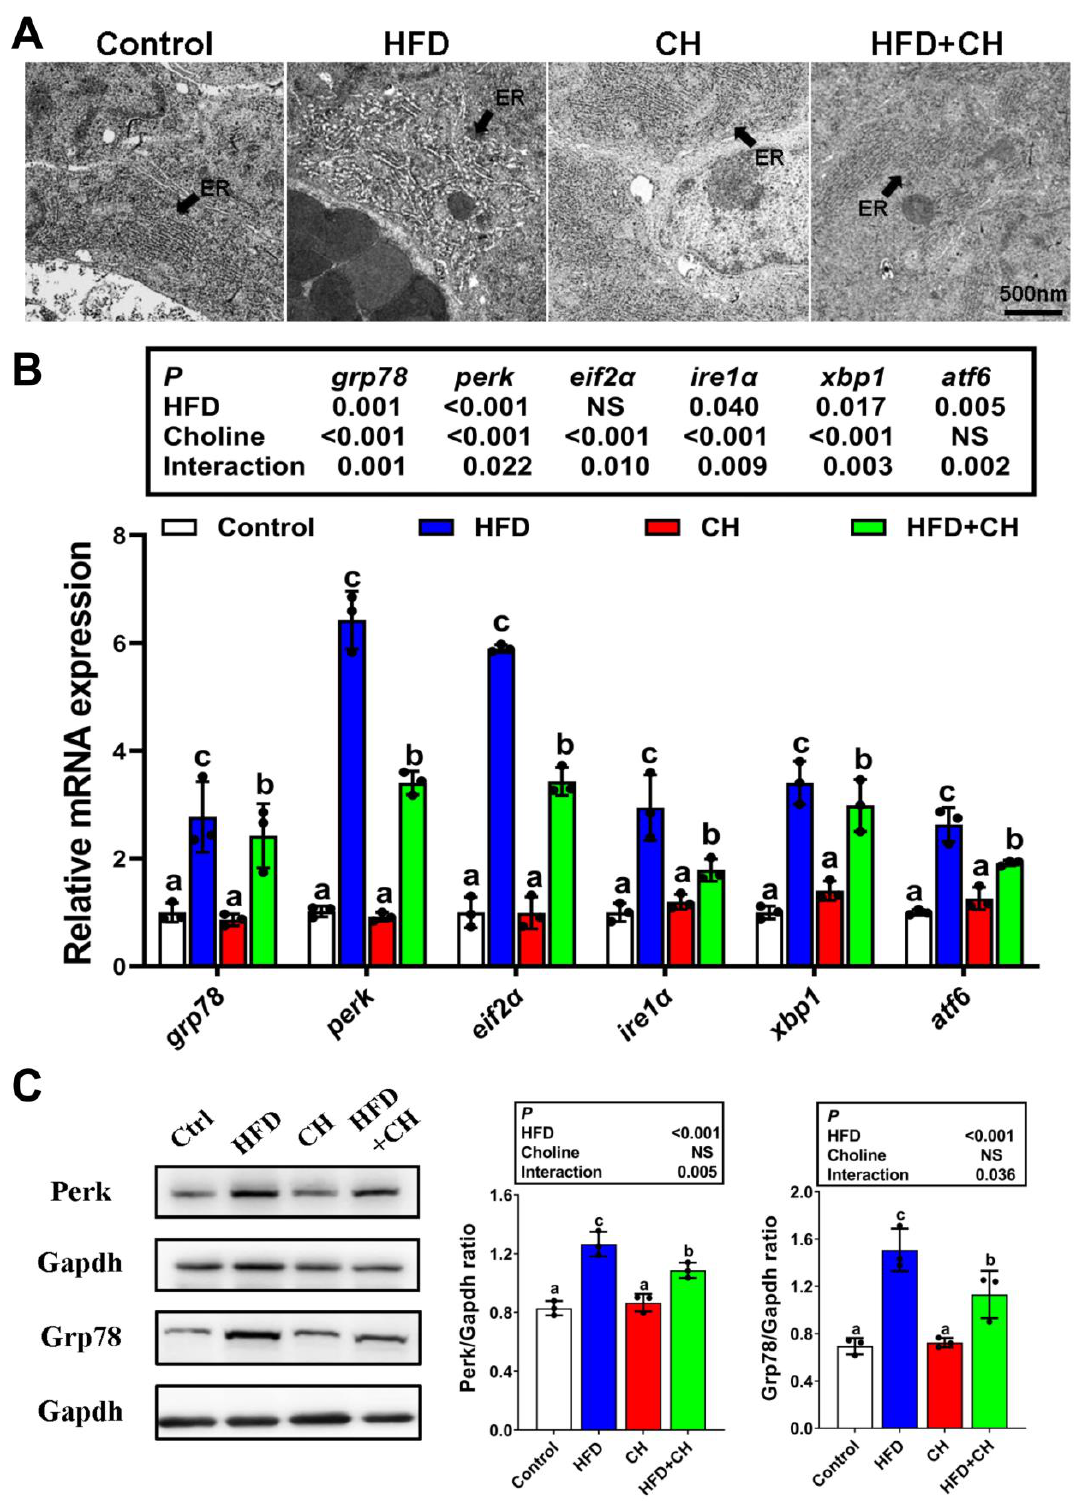
Figure 3. Alleviated effects of dietary choline on HFD-induced UPRer. ( A ) TEM structures of the intestinal endoplasmic reticulum (ER). Scale bars, 500 nm. ( B ) mRNA levels of the genes related to UPRer. ( C ) Western blot and quantification analysis for Perk and Grp78. Data are mean ± SEM, n = 3. Labeled means without a common letter differ, p < 0.05 (2-factor ANOVA, Duncan’s post hoc test). NS, not significant ( p ≥